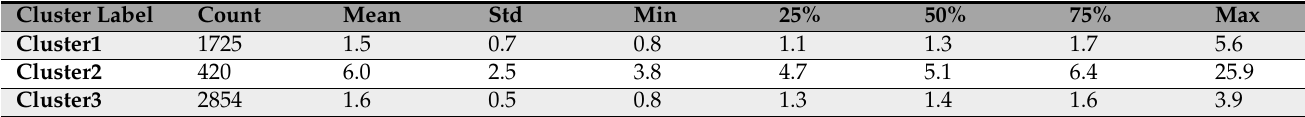
Table 5. HVAC consumption description—second SOM.